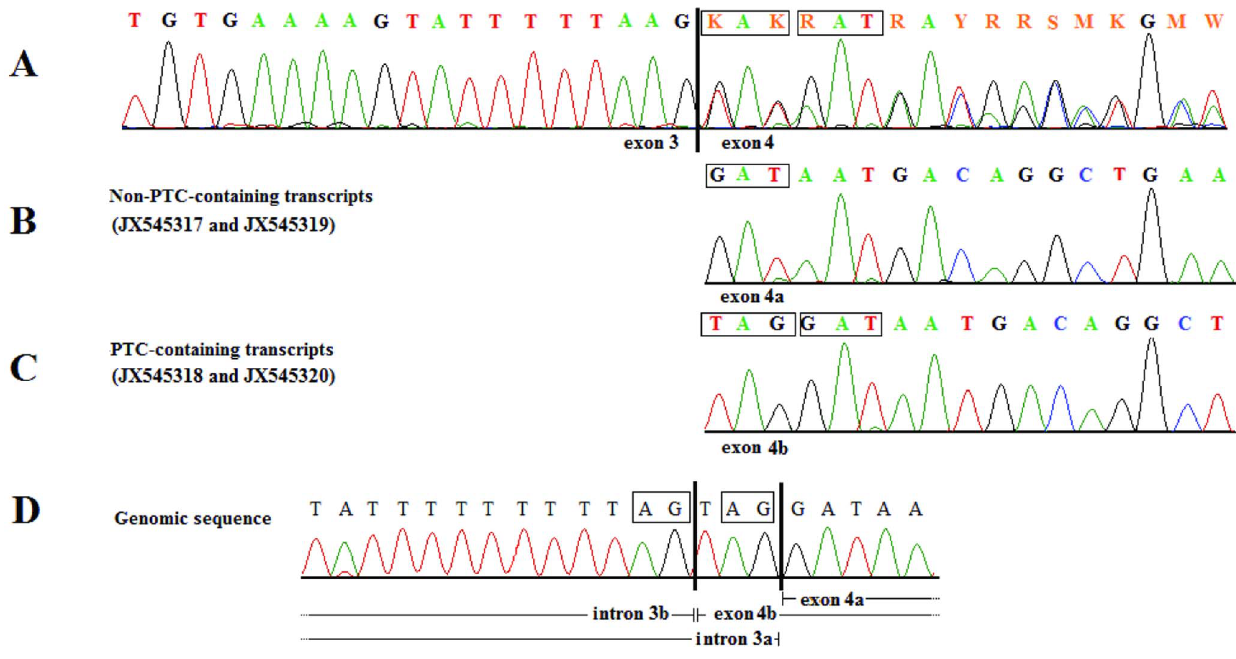
Figure 2. Chromatograms of transcripts detected in equine PLCz1 . (A) The sequences of all animals tested show both adjacent splice sites of the cDNA. Both, forward and reverse sequences show ambiguous double traces when elongation passes exon boundary. (B, C) Visualization of single trace sequence is used to portray each single transcript. (B) For the transcripts without a premature termination codon (PTC), exon 4a starts with the residues GAT, (C) whereas PTC-containing transcript variants harbor an extended exon 4b and start with the residues TAG. (D) Genomic sequence was used to illustrate usage of adjacent acceptor splice sites AG-TA for PTC-containing transcripts and AG-GA for non-PTC-containing transcripts. Vertical lines mark the exon/exon boundary or intron/exon boundary, respectively. The black open boxes indicate specific nucleotide residues used.